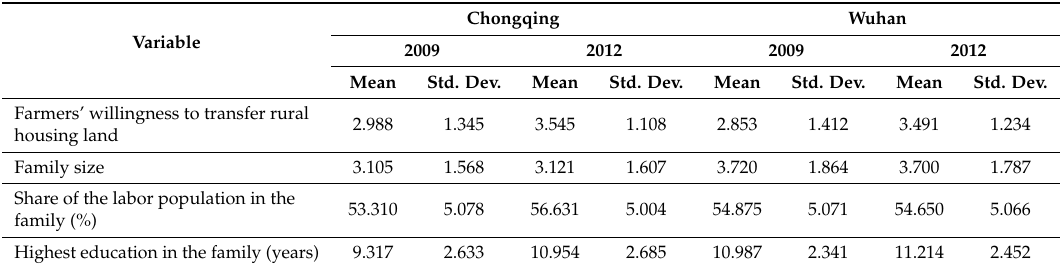
Table 2. Results of the statistical